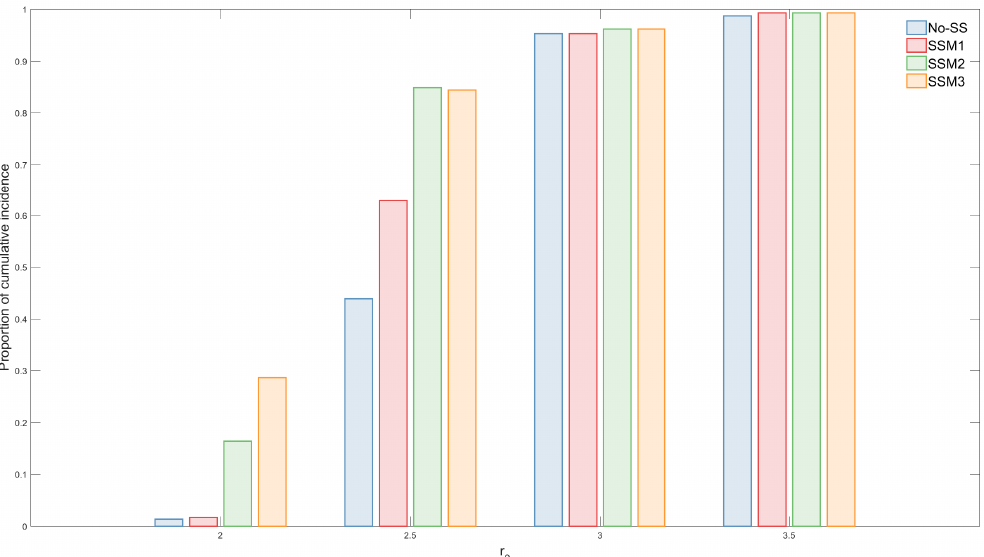
Figure 9. The impact of the effective radius r 0 is shown under four models. In all models, the peak size increases rapidly as r 0 increases. The difference is most significant in SSM 3. The change of proportion of cumulative incidence while varying the different values of r 0 is shown that, in each model, the outbreak probability increases rapidly as r 0 reaches a certain range of values.